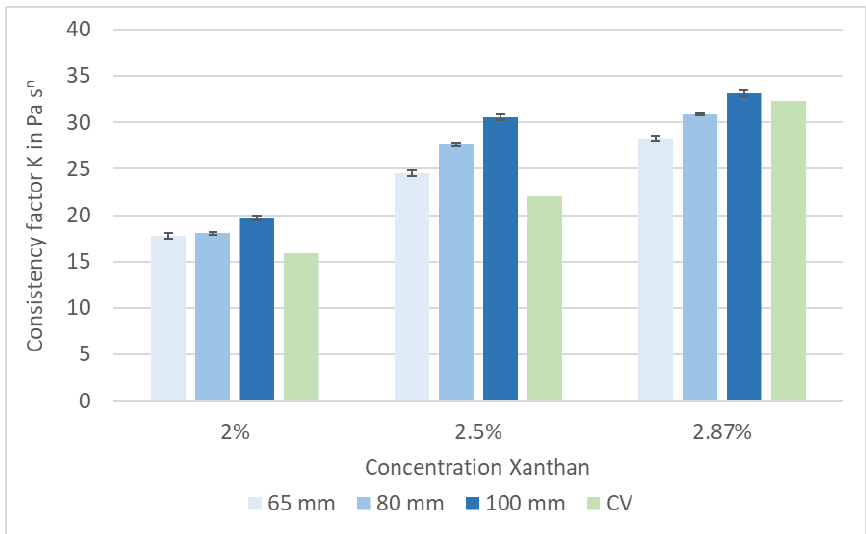
Figure 4. Xanthan solution: consistency factor K, measured with a pipe viscometer with different diameters and with a capillary viscometer (CV).